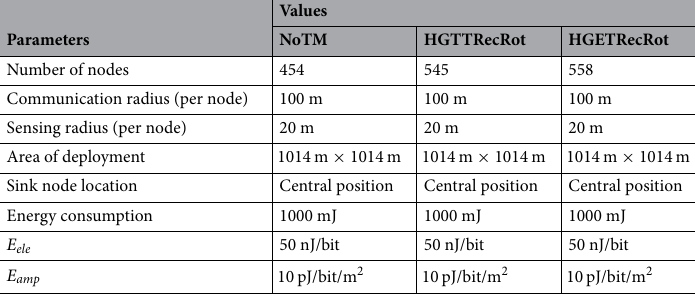
Table 2. Values of the parameters of the network.